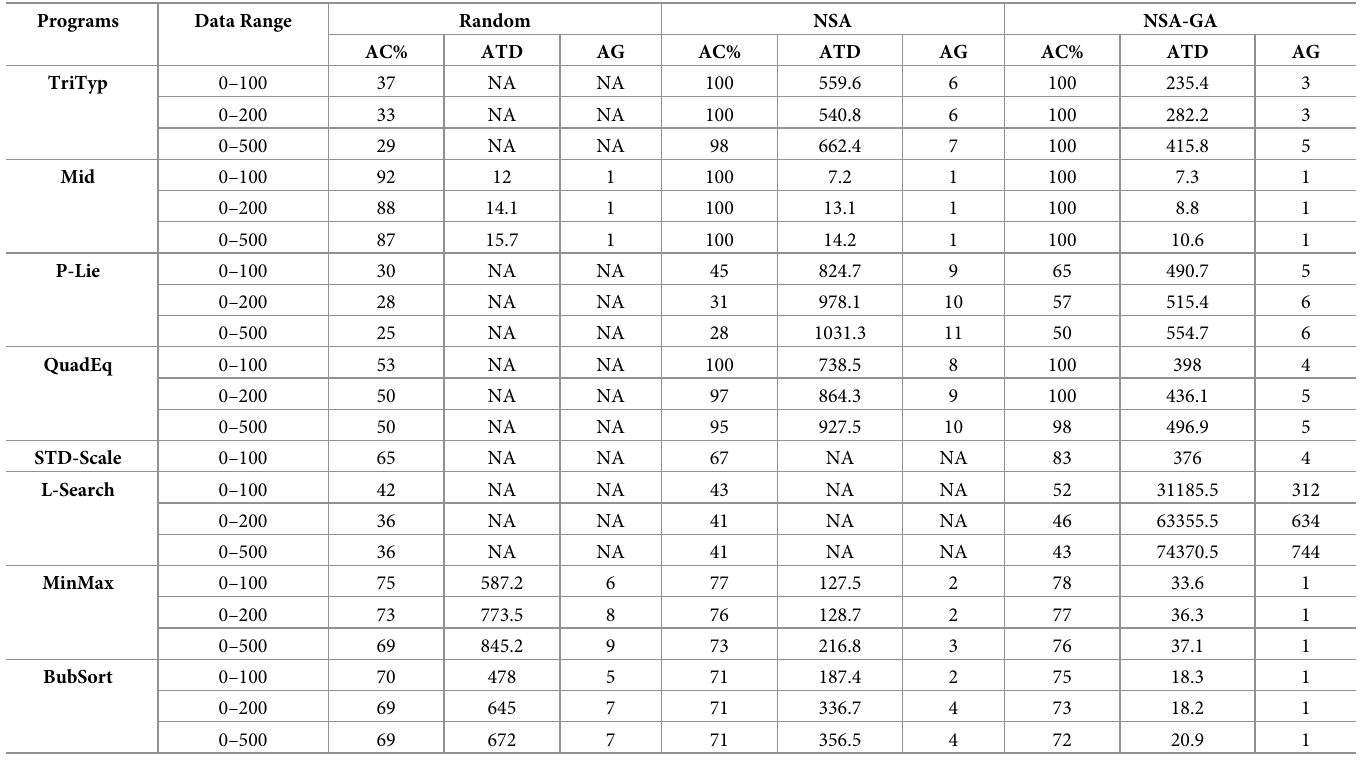
Table 3. Comparison of results between NSA-GA, NSA, and random testing on all programs using float data type and different range. Programs